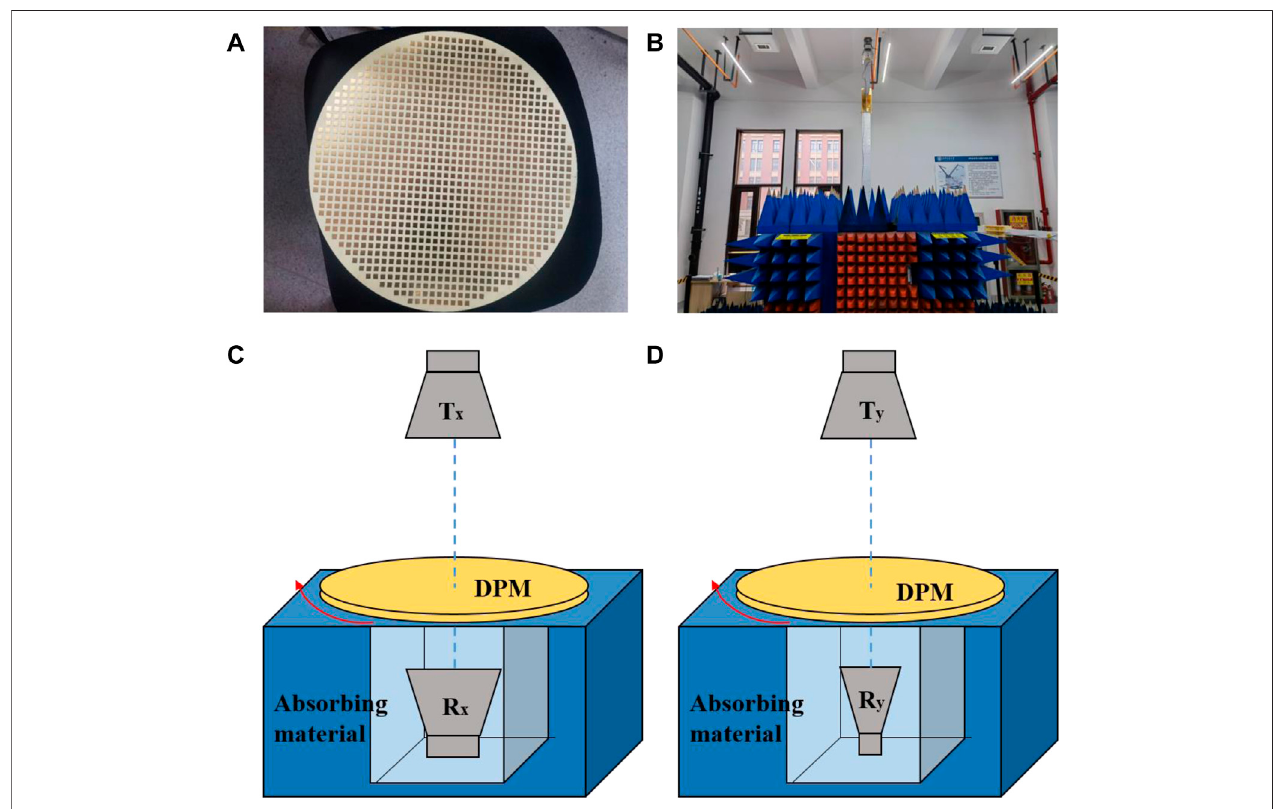
FIGURE 6 | Transmission coef fi cients measurement setup for DPM. (A) The proposed circular metasurface with DPM units. (B) The measurement con fi guration. (C,D) : The switching between R x and R y is realized by rotating the same horn antenna by 90 ° .